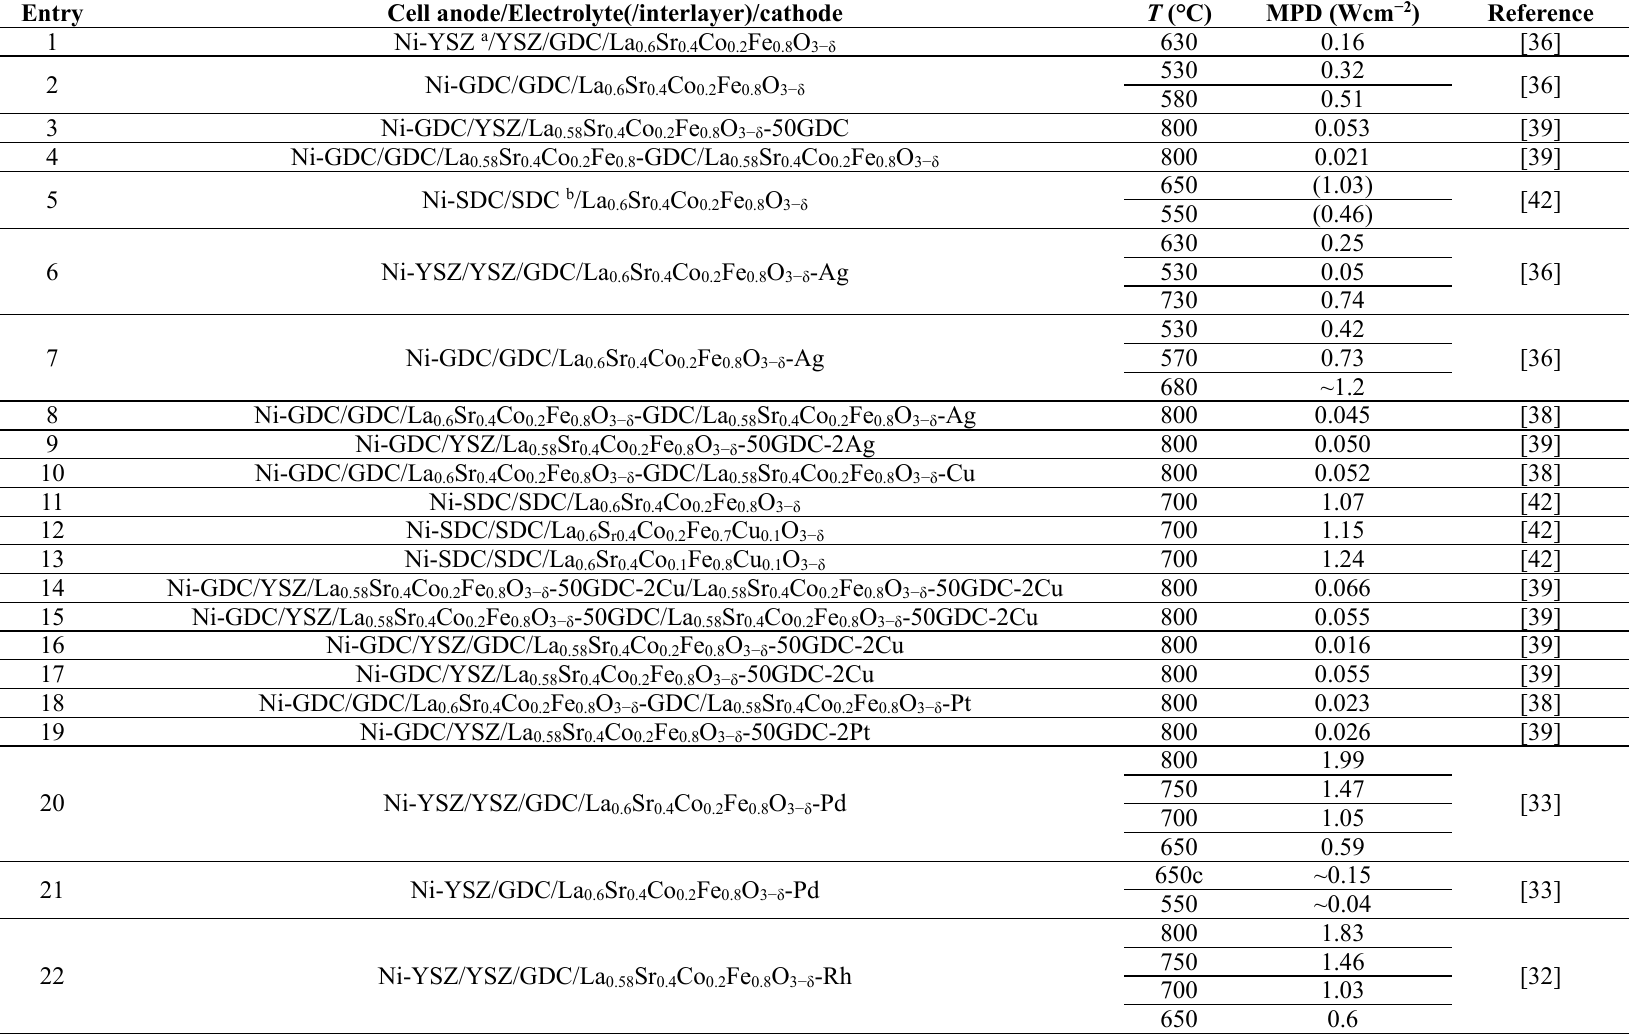
Table 2. Summary of fuel cell performance, cell components and maximum power density (MPD) values at different